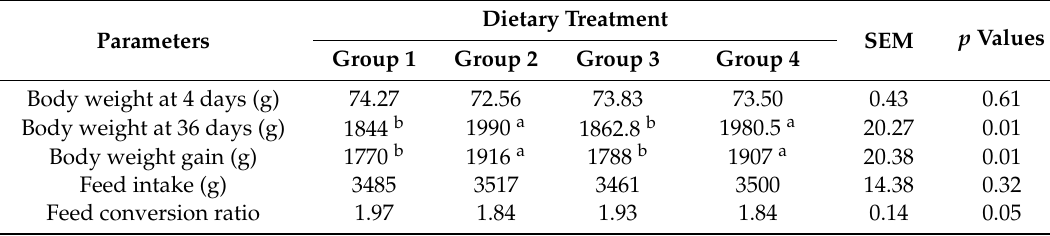
Table 4. Growth performance parameters of broilers chickens fed di ff erent species of microalgae for 32 days.